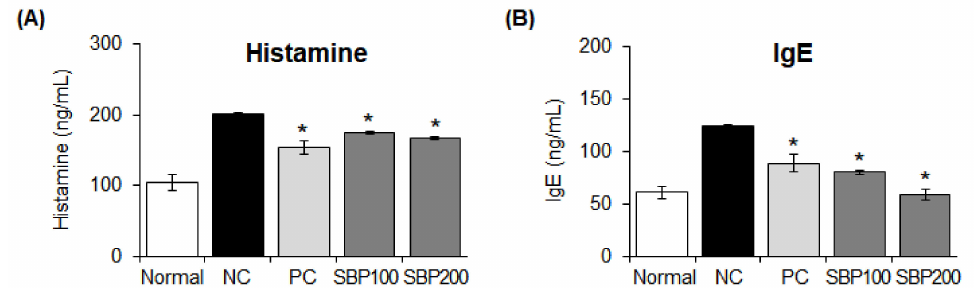
Figure 9. Effect of SBP extract on allergy mediator production in OVA/Alum − sensitized mice. Levels of ( A ) histamine and ( B ) IgE were measured in the plasma of OVA/Alum − sensitized mice treated with the SBP extract for four weeks. Data are expressed as mean ± SEM. Significantly different from the NC group (* p < 0.05). SBP, sword bean pod; NC, negative control; PC, positive control.